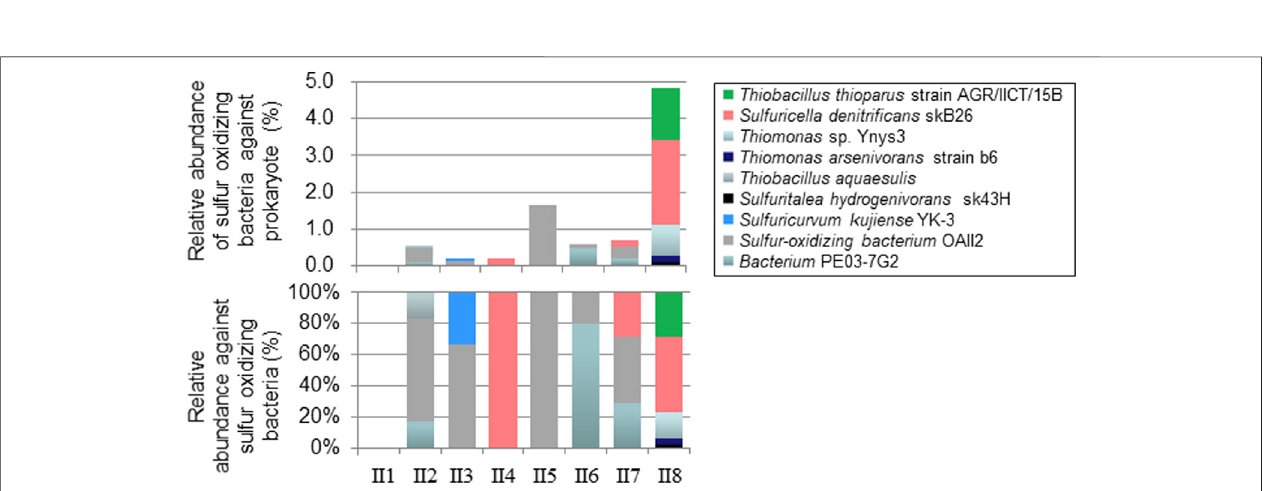
FIGURE 9 | Relative abundances of sulfur-oxidizing bacteria at different depths in the streambank II soils.